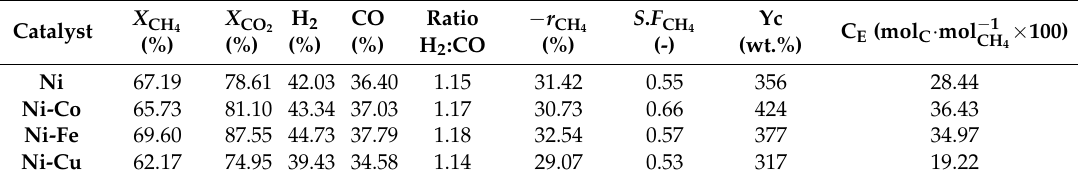
Table 4. CH 4 and CO 2 conversions, syngas H 2 and CO concentrations ( v : v , dry basis), H 2 :CO ratio, and reaction rate obtained after 5 min on stream and CH 4 sustainability factor, carbon yield, and carbon efficiency obtained after 360 min on stream at 700 °C and 100 mL min −1 .